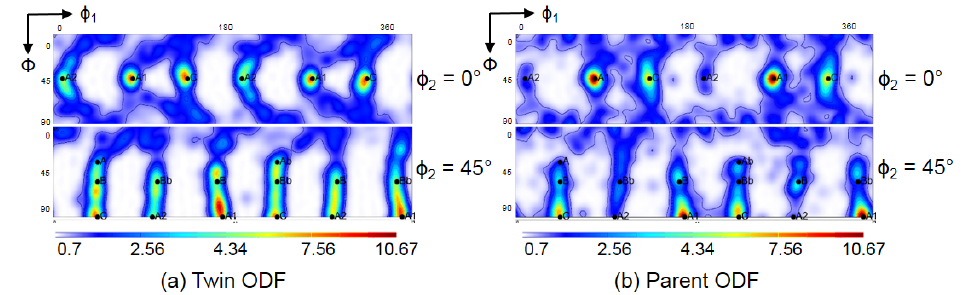
Figure 7. Decomposition of the full, simulated texture obtained by the Taylor model in Figure 6 into ( a ) primary twins only and ( b ) parent grains only. The textures are presented by φ 2 = 0° and 45° ODF sections.